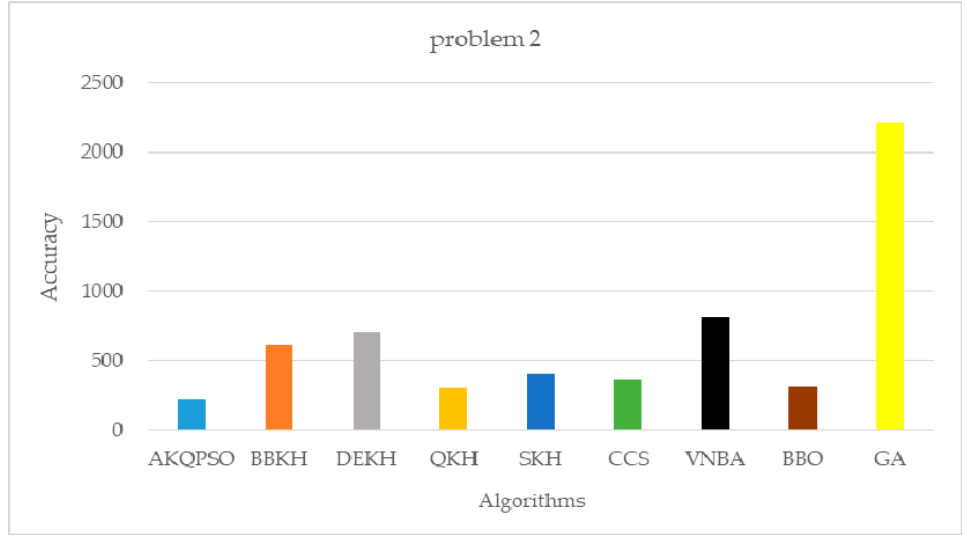
Figure 4. Accuracy of AKQPSO and other algorithms on problem 2: inverse Hilbert matrix problem.